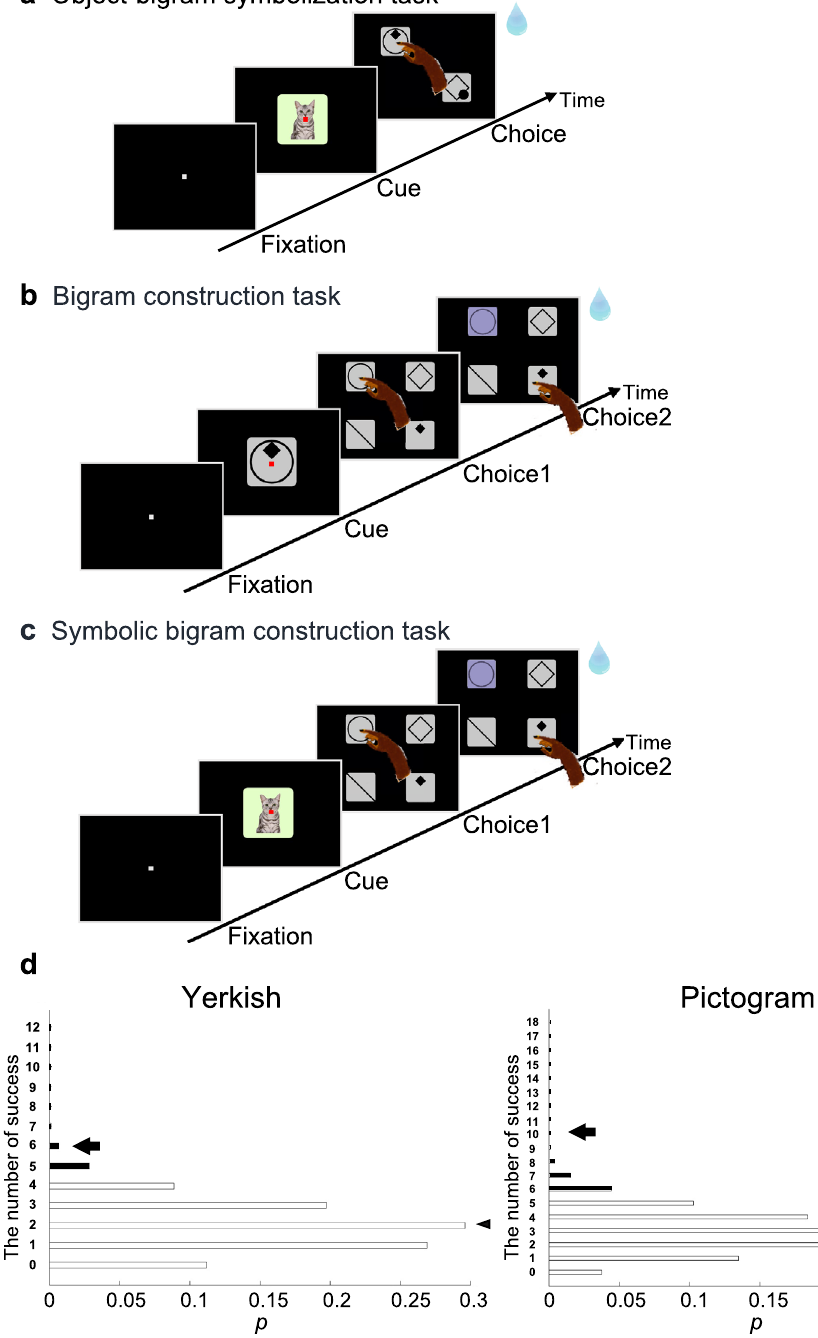
Figure 2. Symbolic construction of a meaningful bigram from meaningless elements in monkeys. ( a ) An object-bigram symbolization task (OBS task). A cue object and two bigrams are subsequently presented on the touch display. The monkeys are required to choose a bigram representing the cue object. ( b ) Bigram construction task (BC task). The monkeys must sequentially choose two elements that constitute the bigram presented as a cue. ( c ) Symbolic bigram construction task (SBC task). The monkeys are required to choose serially the two elements constituting the correct bigram that is not actually presented but is symbolically associated with the cue object. ( d ) The results of the SBC probe tests with the Yerkish (left) and pictogram (right) symbols, plotted on binomial distributions. Arrows indicate the observed number of successes out of 12 trials (left, for 6 stimuli in 2 animals) and 18 trials (right, for 6 stimuli in 3 animals), respectively. Bars represent the discrete probability distributions of the number of successes out of all probe trials. Arrowheads indicate the expected number of successes according to the binomial distribution, provided that the expected success rate is 0.17. Filled bars indicate the significance level of p < 0.050 with the one-tailed exact binomial